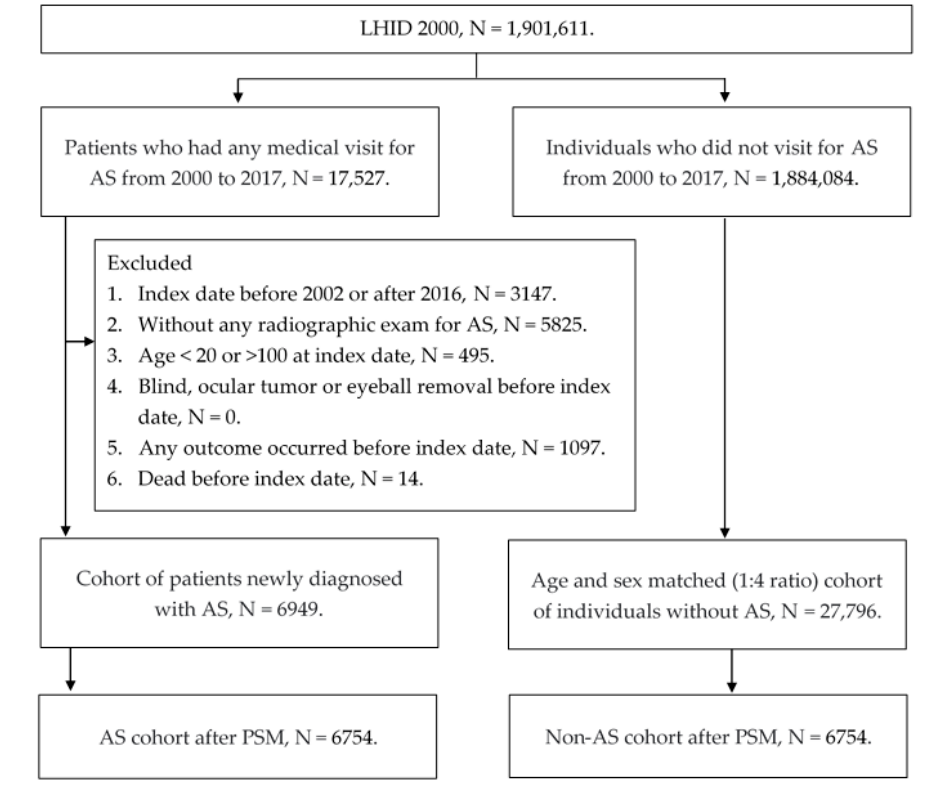
Figure 1. The flowchart of participant selection. N: number, AS: ankylosing spondylitis, PSM: pro- pensity score-matching.